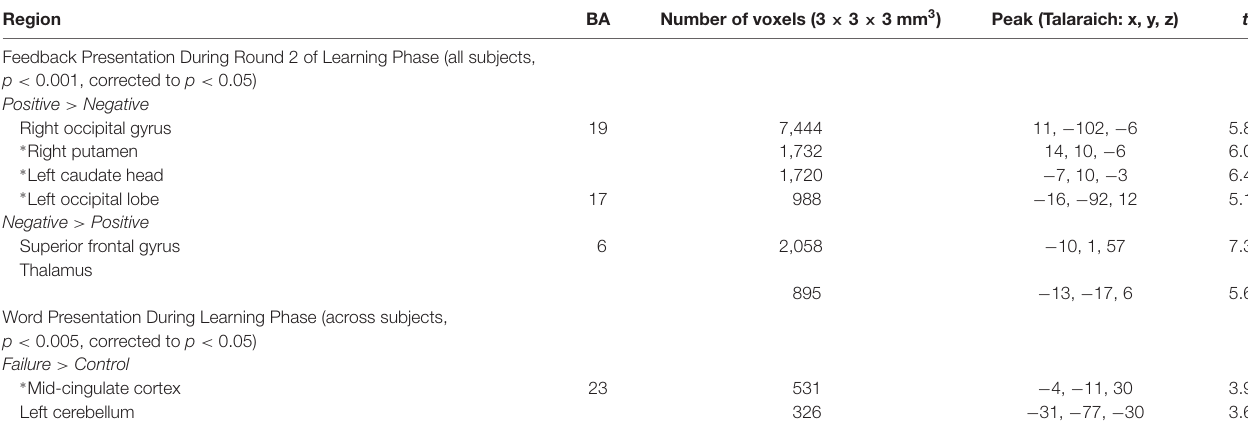
TABLE 1 | Brain regions identified by GLM analysis.